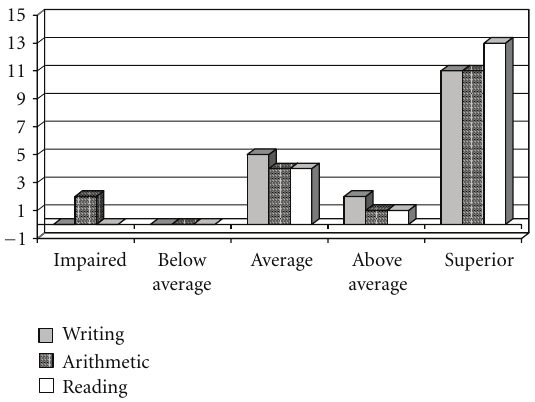
Figure 4: Performance of the control group (CG) on the writing, arithmetic, and reading